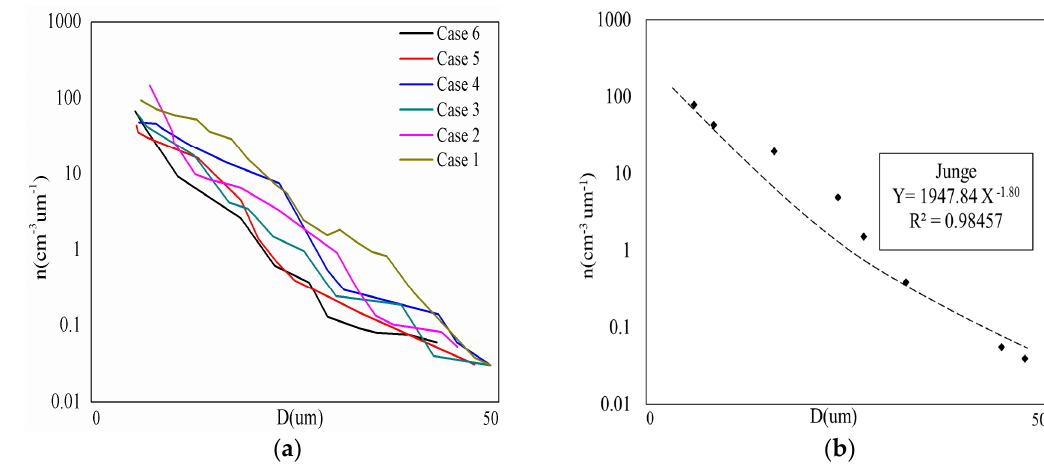
Figure 4. Fog droplet size distribution characteristics of six fog processes ( a ), and the average spectrum of fog droplet size distribution ( b ).